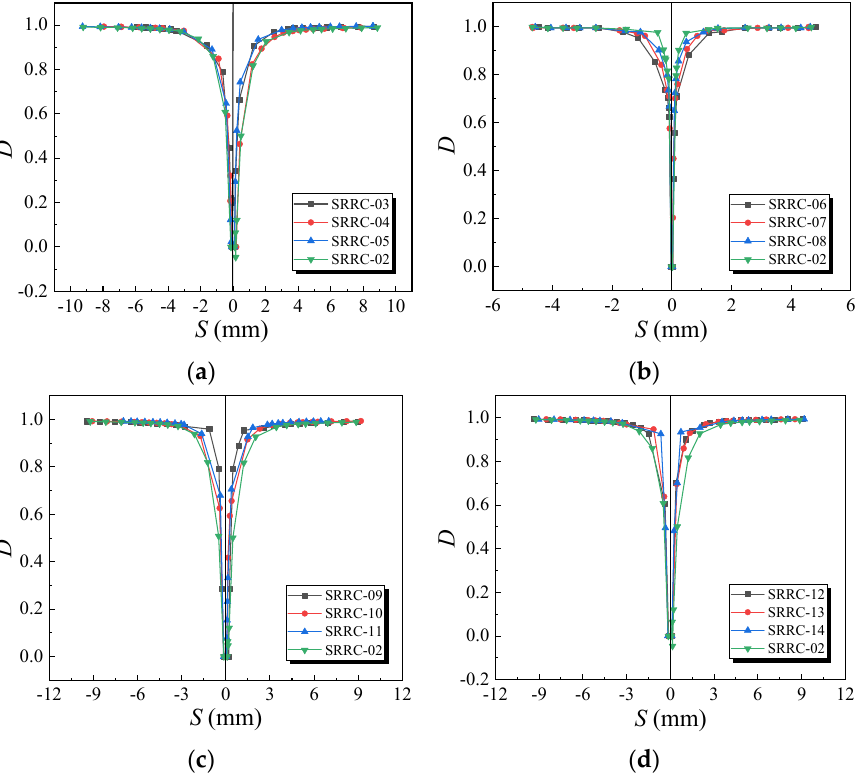
Figure 10. Influence of different factors on interface damage curves, they should be listed as: ( a ) Influence of r ; ( b ) Influence of C ss ; ( c ) Influence of ρ sv ; ( d ) Influence of f c .